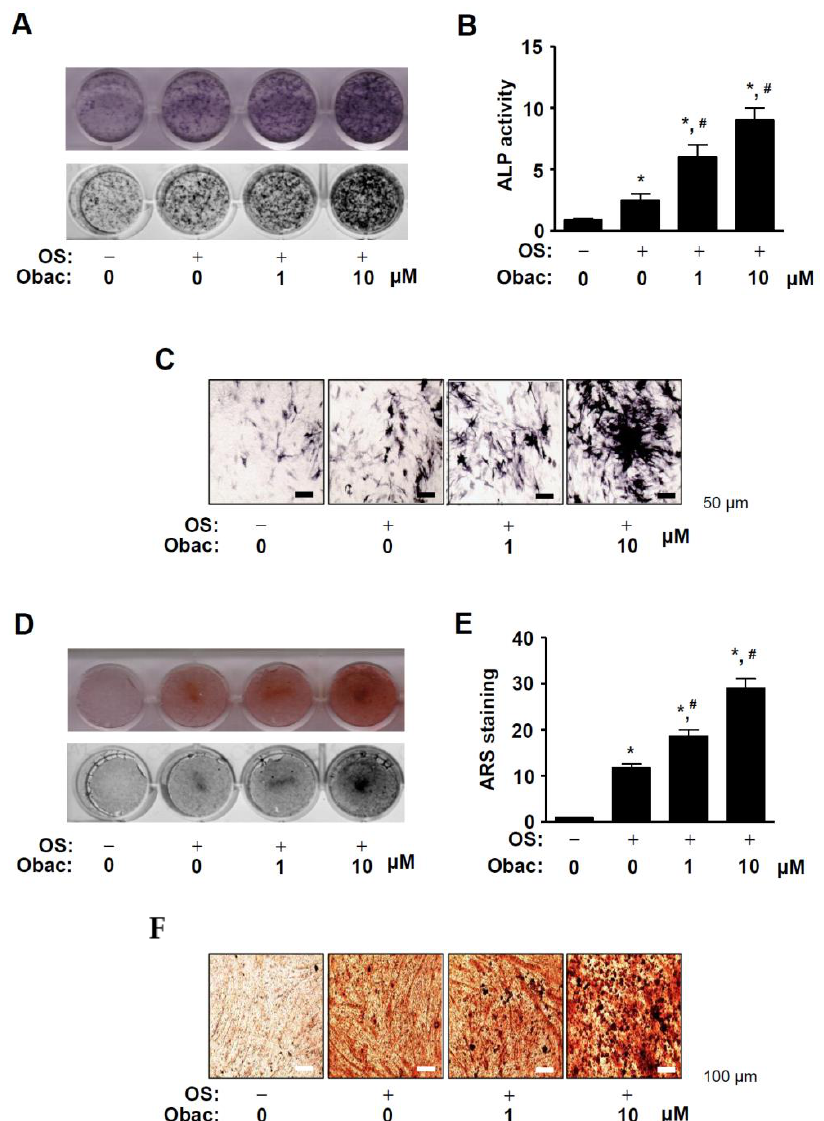
Figure 3. Effects of Obac on early and late osteoblast differentiation. ( A – C ) MC3T3-E1 was incubated in OS with Obac (1–10 µ M) for 7 days. ALP staining was detected using a scanner (upper) and a colorimetric detector (bottom) ( A ), the enzymatic activity of alkaline phosphatase (ALP) was measured at 405 nm using a spectrophotometer ( B ), and ALP-positive cells were observed using a light microscope ( B ). Scale bar: 50 µ m. ( D – F ) After osteoblast differentiation for 14 days, the mineralization formation was analyzed using Alizarin red S (ARS) staining. The ARS staining was detected using a scanner (upper) and a colorimetric detector (bottom) ( D ), quantified by measuring at a wavelength of 590 nm using a spectrophotometer ( E ), and the mineralized nodules were observed using a light microscope ( F ). Scale bar: 100 µ m. Data are representative of three independent experiments, and values are expressed as the mean ± S.E.M. * p < 0.05 indicates statistically significant differences, compared with the control. #: statistically significant difference compared with OS ( # p <